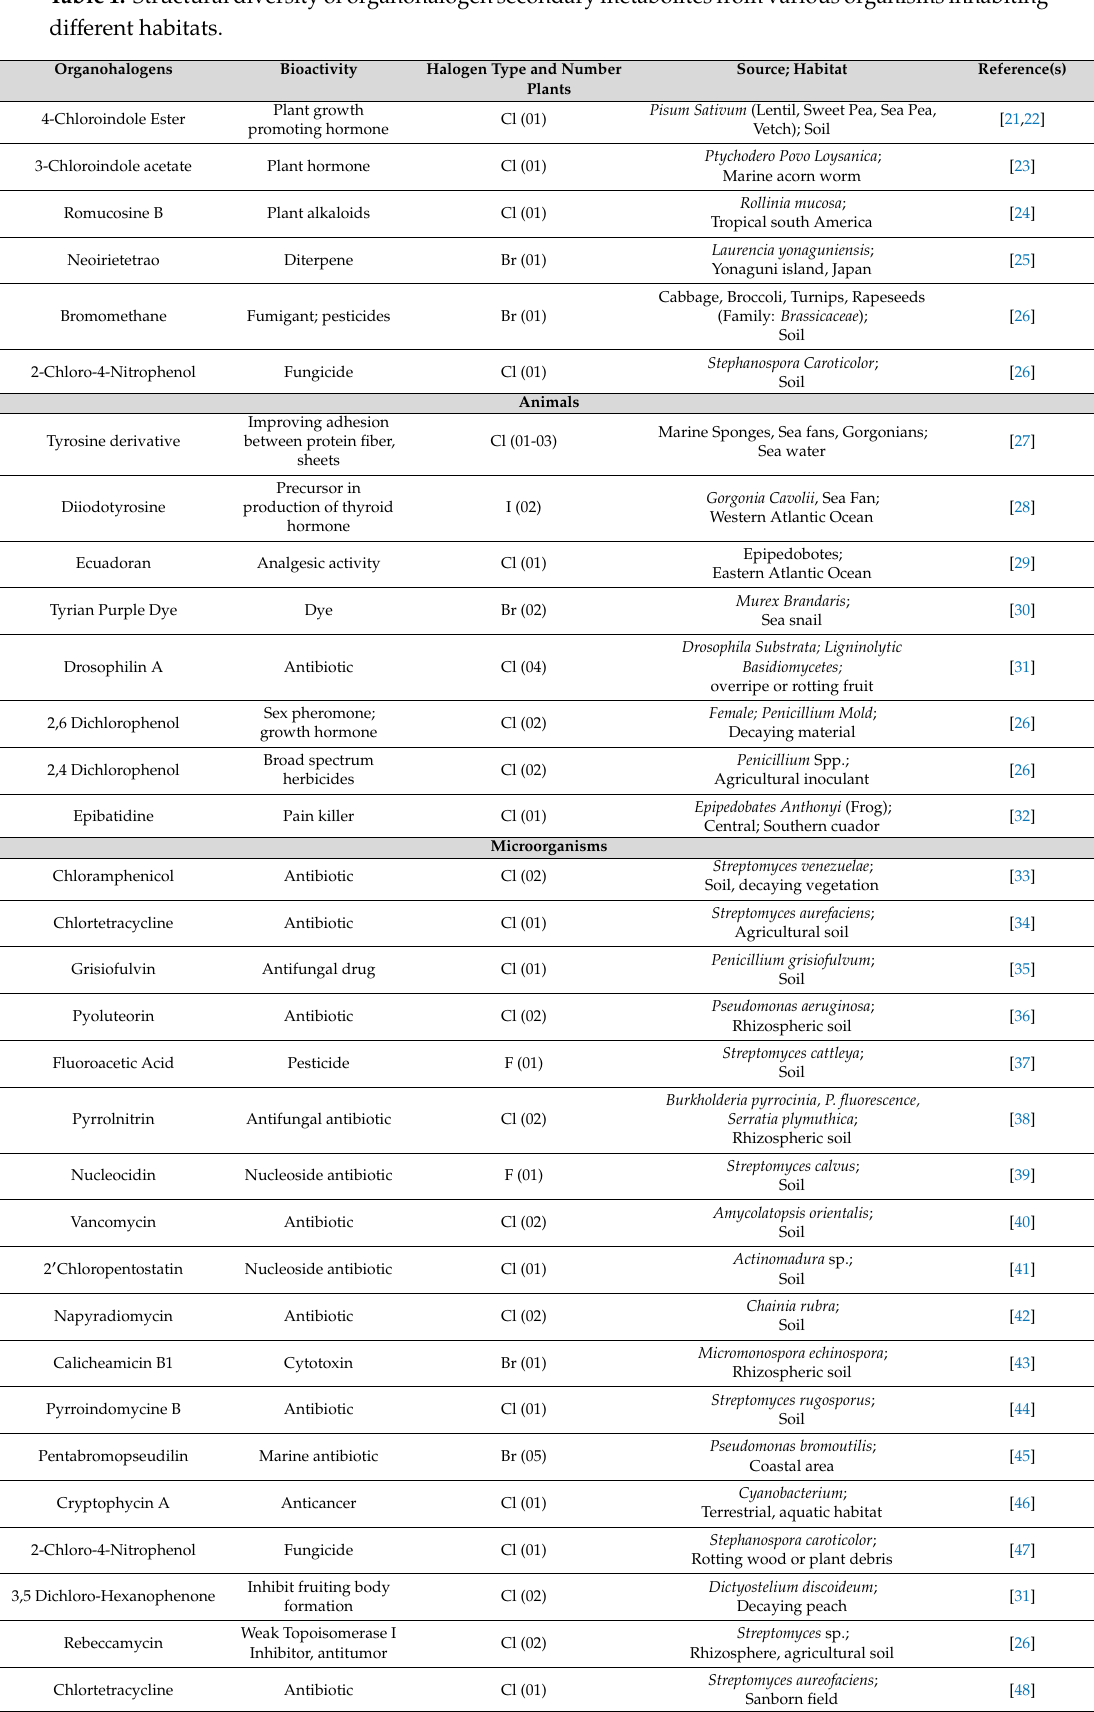
Table 1. Structural diversity of organohalogen secondary metabolites from various organisms inhabiting di ff erent